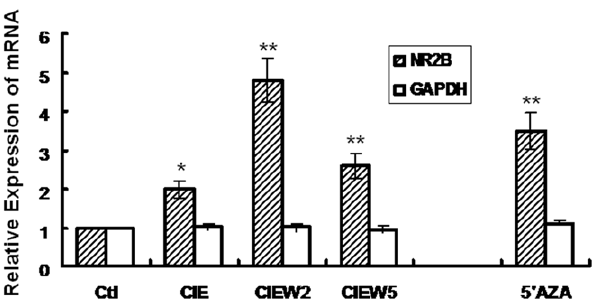
Figure 2. 5 9 AZA induced up-regulation of NR2B gene expres- sion. The cortical neuronal cultures were treated by ethanol in CIE regimen or 5 9 AZA (48 hrs), respectively. Total RNA was isolated and real time PCR for NR2B and GAPDH mRNA expression was performed. Results are presented as the mean ratio to control 6 SEM; *, p , 0.05; **, p , 0.01 compared with control levels.